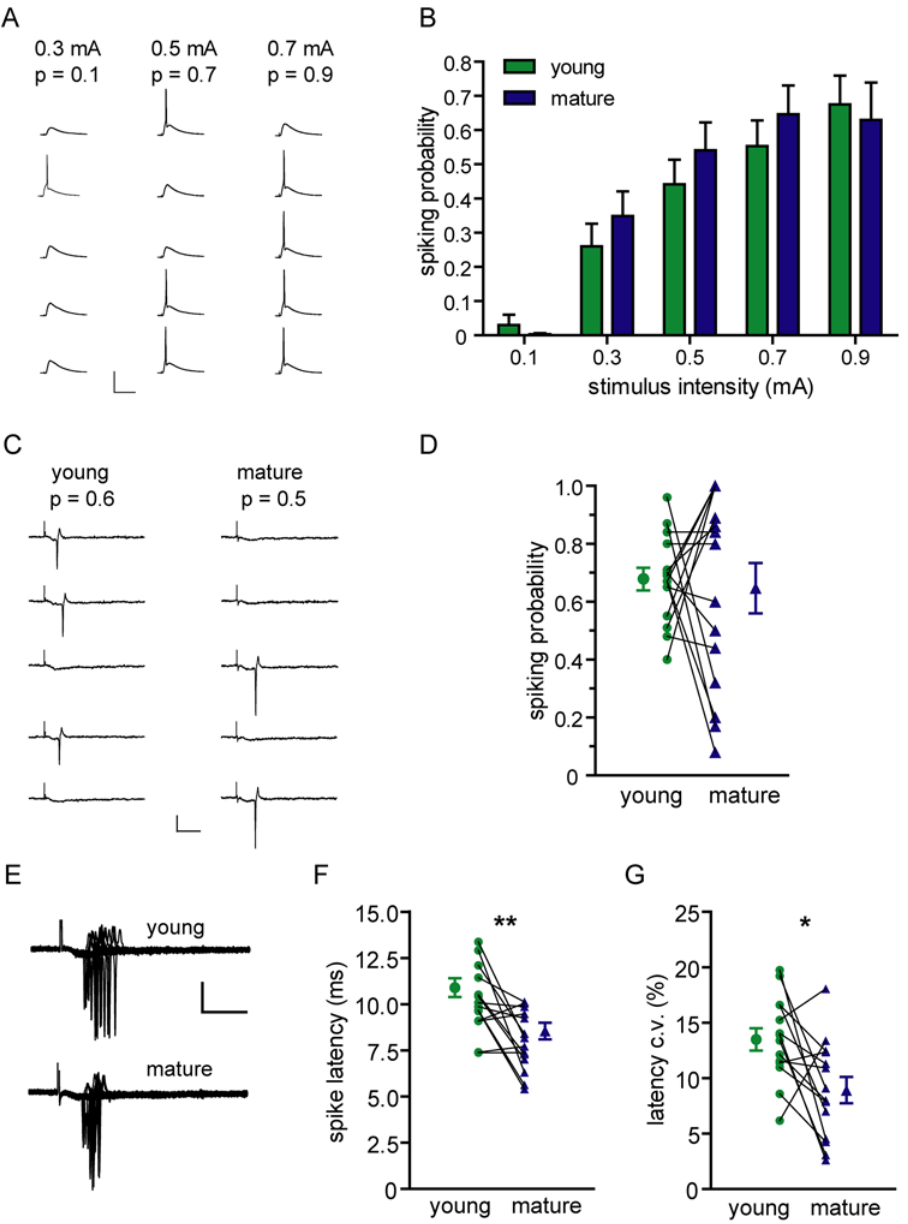
Figure 3. Equalized firing in young and mature neurons. (A) Example of a recording performed to measure spiking probability in response to presynaptic stimuli of different intensities in the same neuron. Each column shows typical membrane potential traces in response to stimuli repeated at low frequency (0.07 Hz). Probabilities are shown on the top. Scale bars: 50 mV, 100 ms. (B) Quantitative analysis of spiking probability. Each experiment involved consecutive recordings of a young and a mature neuron at all stimulus intensities in the same slice. Two-way ANOVA revealed no differences between young and mature cells ( p =0.36), but a significant effect was observed for stimulus intensity ( p , 0.0001). Bars represent mean 6 SEM of 39 neuron pairs from 27 slices. (C) Example of paired measurements of spiking probability in a young and a mature neuron in dual cell- attached recordings. Action currents elicited by repetitive stimuli delivered at low frequency (15 repetitions at 0.06 Hz) were recorded to simultaneously assess spiking probability in both neurons. A subset of 5 epochs is shown. Scale bars: 20 pA, 10 ms. (D) Paired analysis of spiking probability measured in 15 experiments. Each recorded pair is connected by a line; mean 6 SEM are shown. A paired two-tailed t -test revealed no statistical differences between the groups ( p =0.77). (E) Overlay of action currents in simultaneous cell-attached recordings of young and mature neurons. Note the enhanced jitter in young DGCs. Scale bars: 20 pA, 10 ms. (F) Measurements of spike latency analyzed by a paired two-tailed t -test; (**) denotes p =0.0062 with N=14 pairs. (G) Spike jitter measured as the relative coefficient of variation (c.v.) for individual action currents; (*) denotes p =0.014 with N=14 pairs. doi:10.1371/journal.pone.0005320.g003 Voltage-gated Na + and K + channels displayed a slight age- voltage-gated currents were close to plateau levels in young dependent increase, consistent with the observed changes in action neurons. Consistent with this notion we observed only a minor potential threshold and shape. This minor increment indicates that increase in the rising slope of the action potential, a parameter that